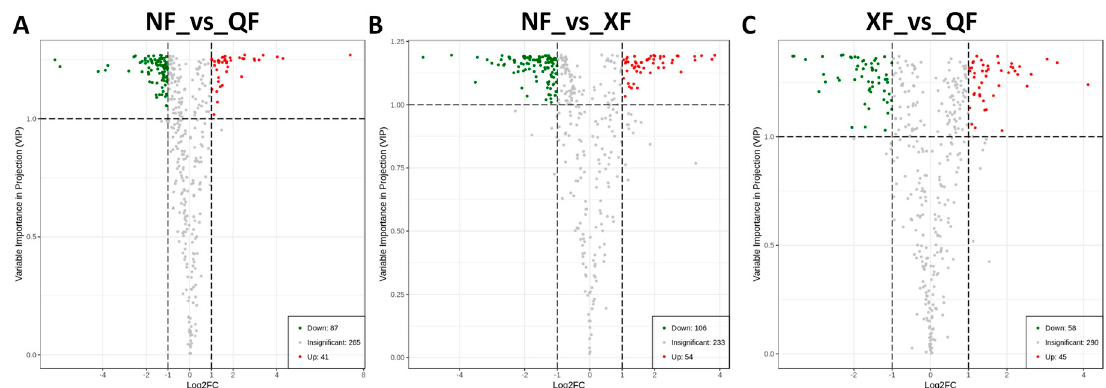
Figure 3. Volcano plots depicting the up- and down- accumulated metabolites between pairs of samples from different growing regions. ( A ) between NF and QF; ( B ) between NF and XF; ( C ) between XF and QF. Compounds with variable importance in projection (VIP) ≥ 1 and fold change ≥ 2 or fold change ≤ 0.5 were declared significant. QF, NF and XF represent Qinghai, Ningxia and Xinjiang locations, respectively.